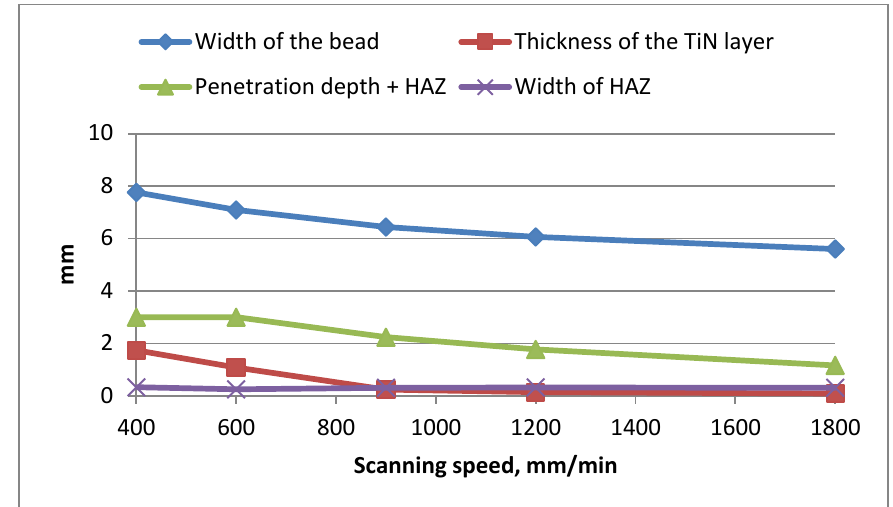
Figure 10. Influence of the scanning speed on the geometry of nitrided surface layers produced at constant output laser power 1800 W (Table 2).